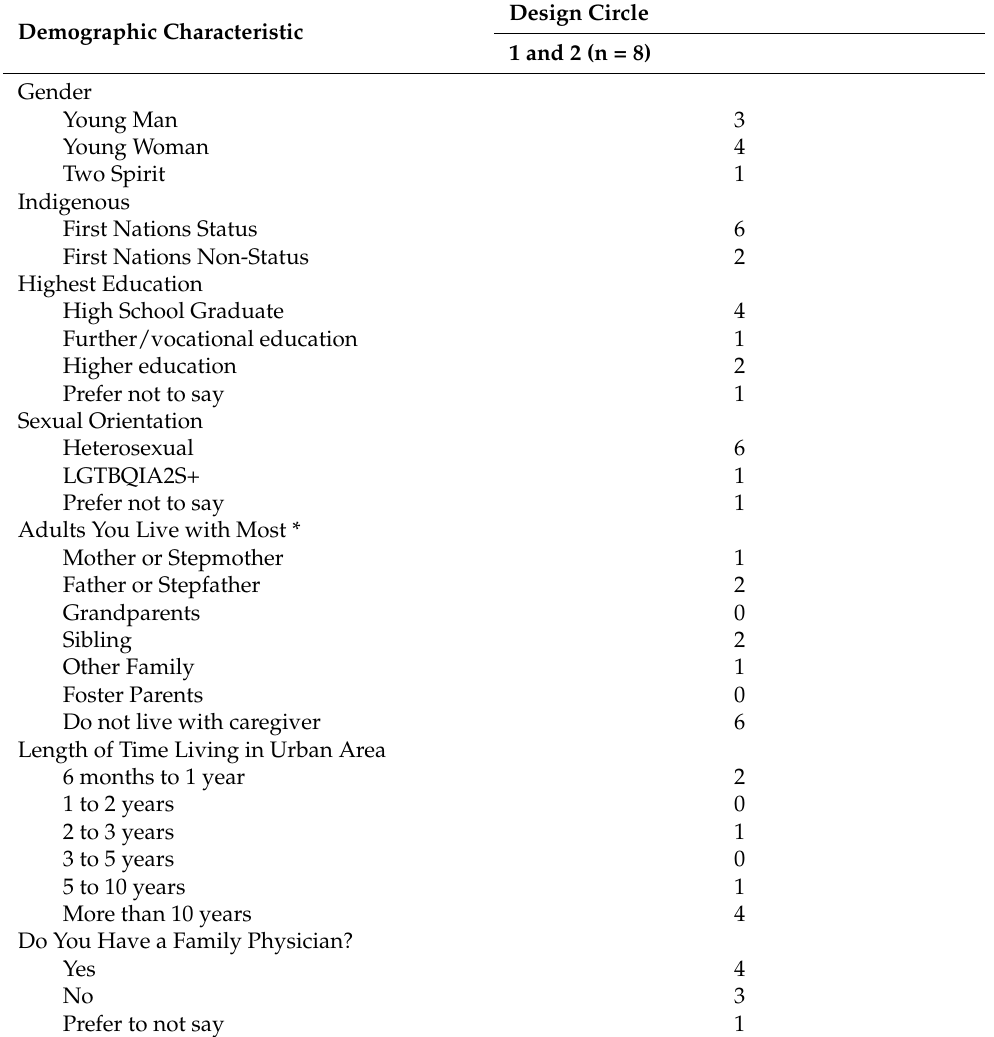
Table 1. Demographic Information for Design Circle Participants.